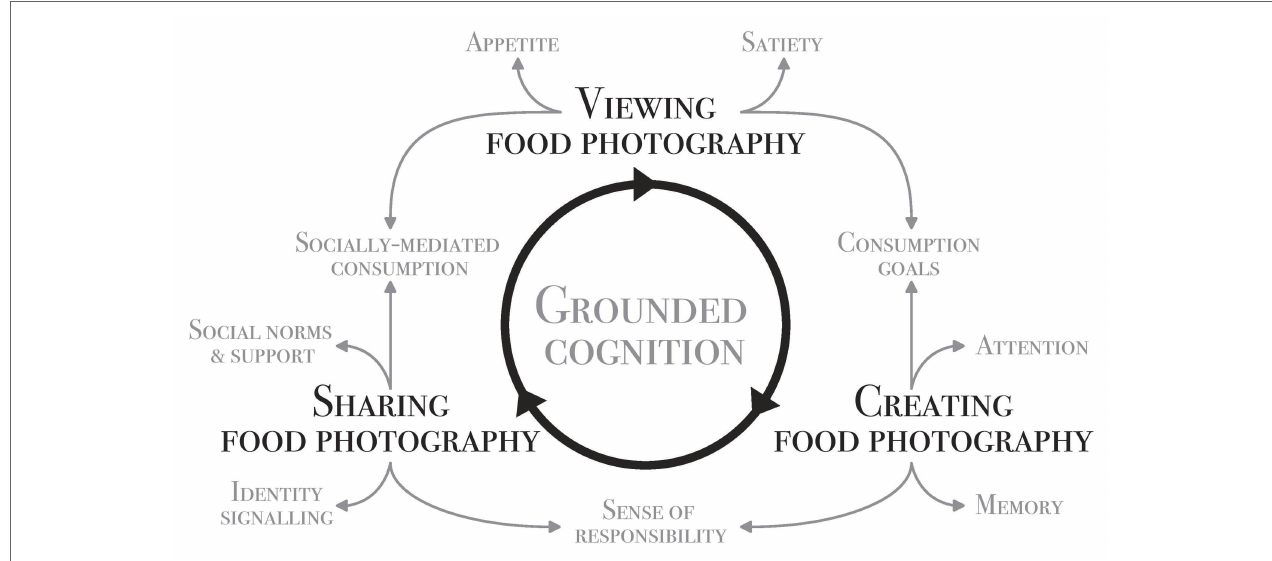
FIGURE 1 | Schematic representation of the digital food photography habits cycle and related